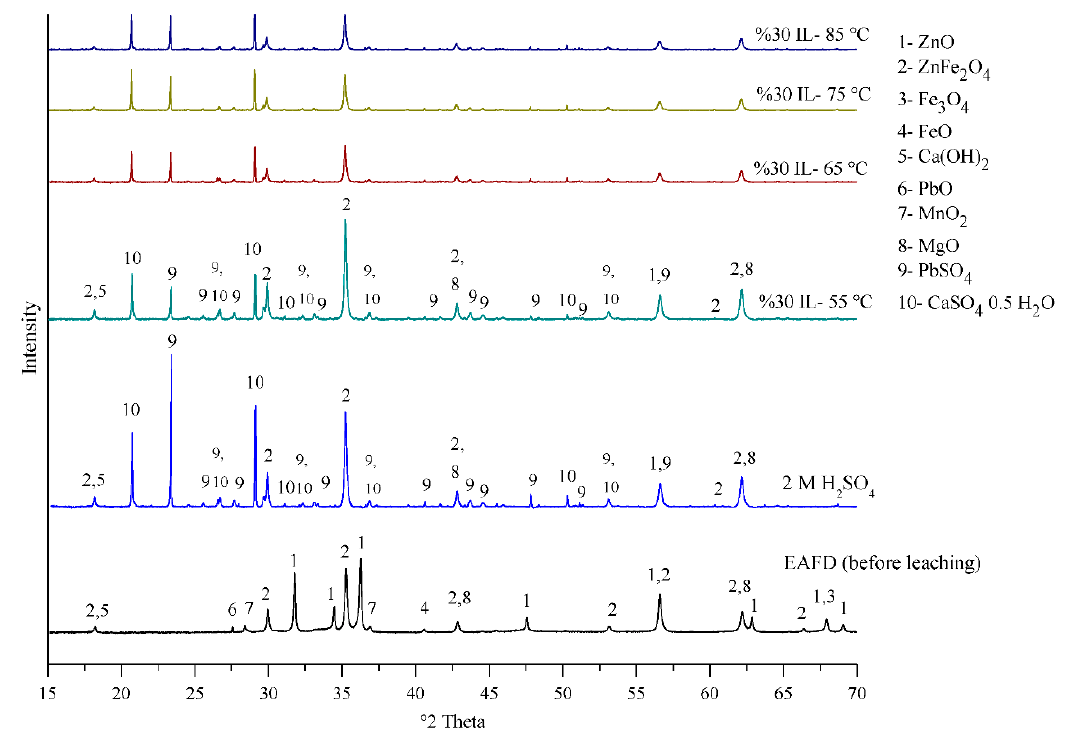
Figure 17. XRD pattern of EAFD before and after leaching in 30% v/v [Bmim + HSO 4 − ] solution at different temperatures (55 to 85 °C) and in 2 M H 2 SO 4 (85 °C) for comparison.